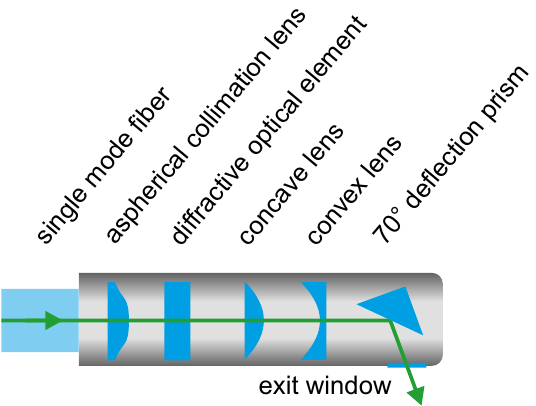
Figure 3. Schematic of the optical set-up within the laser projection unit (LPU): The diffractive optical element is a customized, binary phase mask generating a laser grid of 31 × 31points. All optical elements have an anti-reflective coating for 532nm.